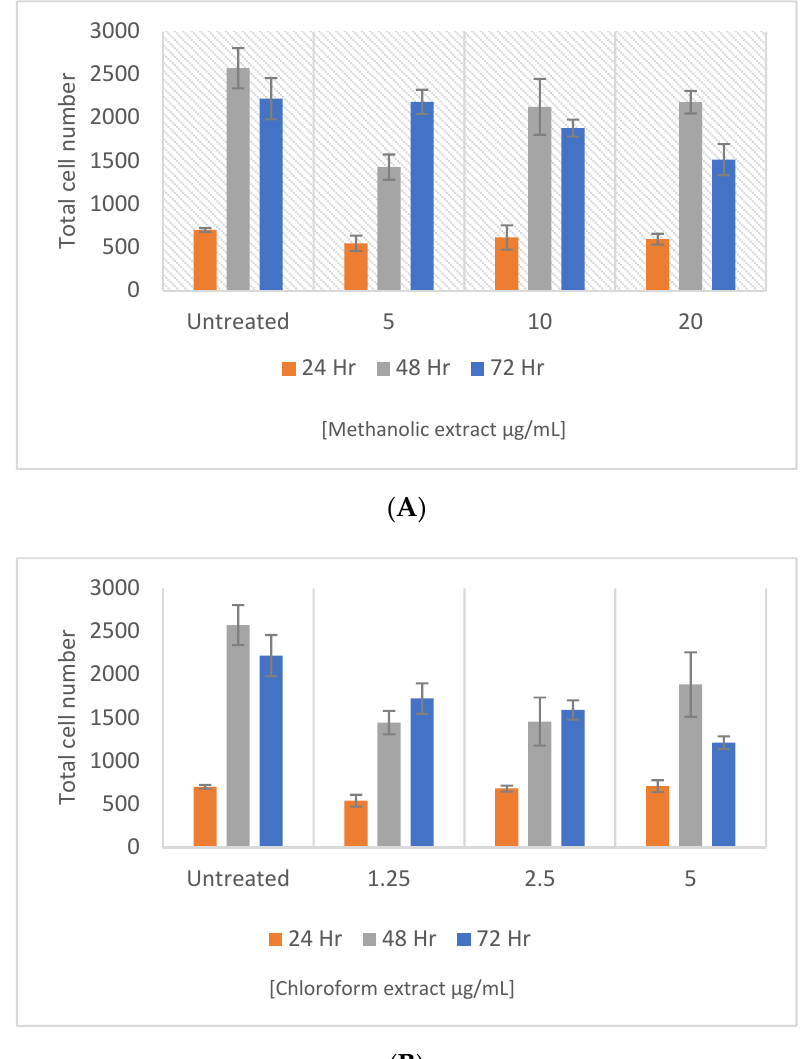
Figure 8. Effect of three samples on the INS-1 pancreatic β -cell proliferation. Cells were stained with Hoechst 33342 and the total cell number was determined after 24, 48, and 72 h of treatment with samples of the methanol extract ( A ) and chloroform extract ( B ). Error bars indicate the standard deviation of the mean of four replicates from a single experiment.